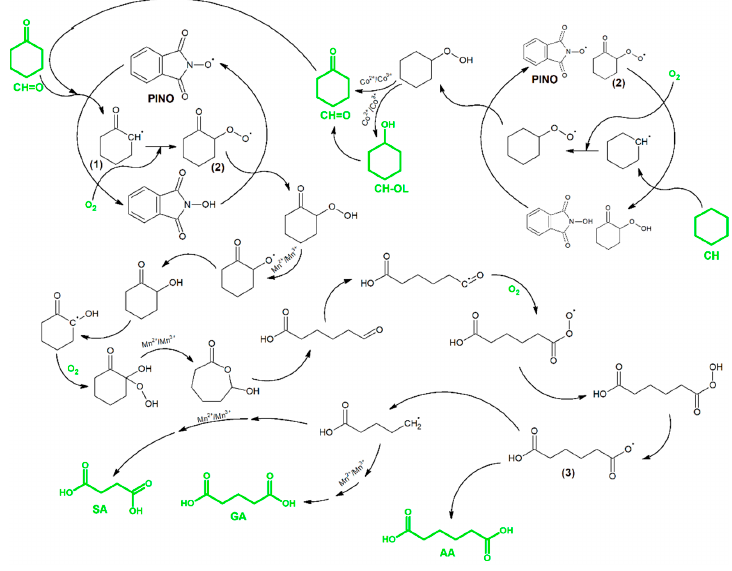
Scheme 3. Proposed mechanism of oxidation of CH/CH=O mixture.